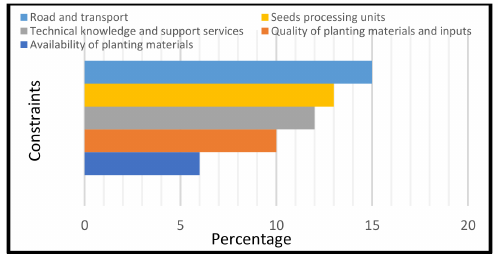
Figure 20. Major constraints.